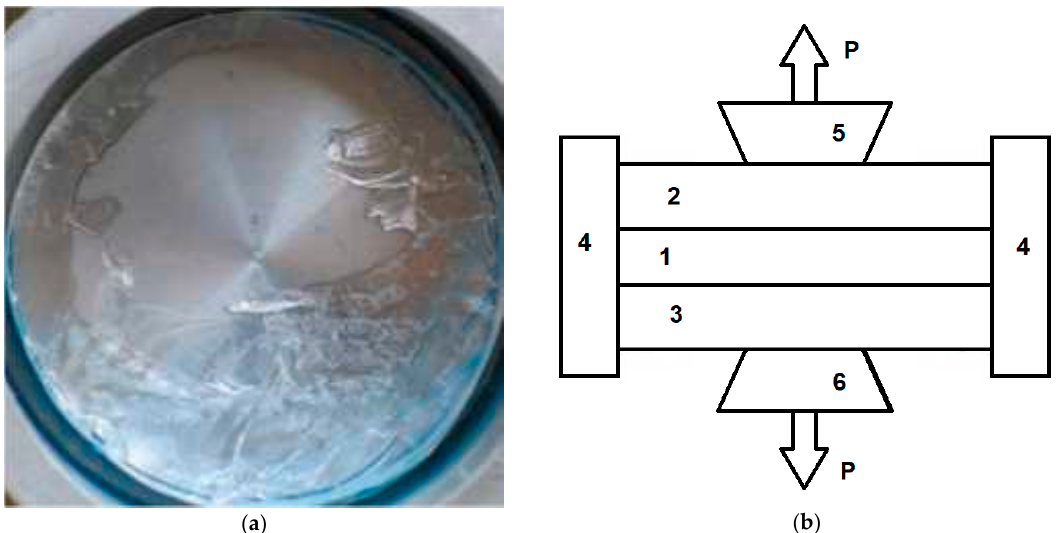
Figure 5. ( a ) A mixed adhesive ‐ cohesive mode of fracture of ice ‐ aluminum contact in tensile adhesion test; ( b ) Scheme of an experimental device for measuring the tensile adhesion strength of ice. 1 — ice slab; 2 and 3 — disks with reference or test surfaces; 4 — guide sleeve; 5 and 6 — clutches; P — applied tensile force.